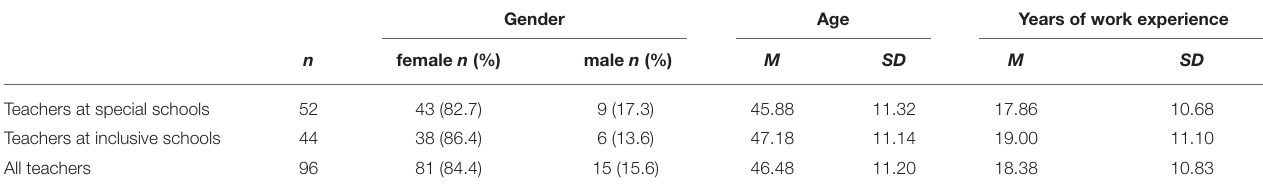
TABLE 1 | Gender, age, and years of work experience.